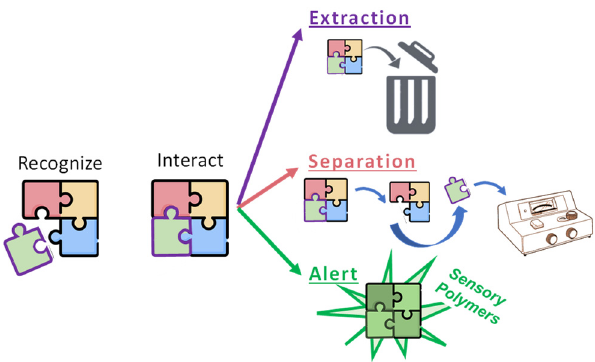
Figure 2. Differences between sensory polymers, polymers for extraction and elimination, and polymers for extraction and separation.